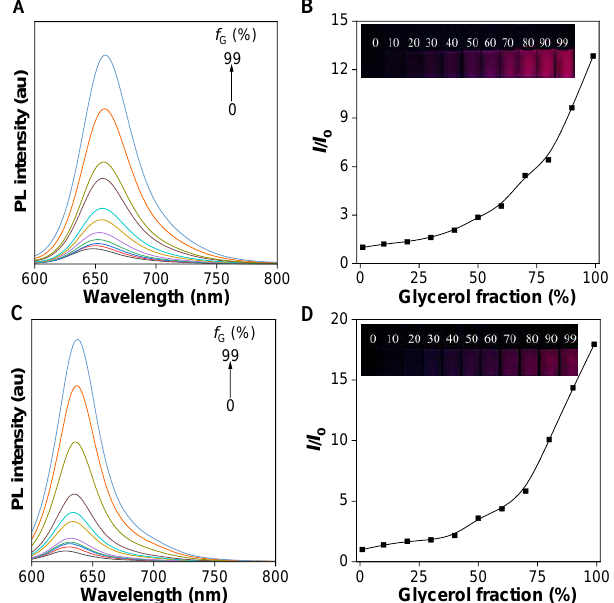
Figure 1. ( A ) PL spectra of TCFISE (5 µ M) in methanol/glycerol mixed solution with different glycerol fractions ( f G ). ( B ) Plot of relative PL intensity (651 nm) of TCFISE (5 µ M) versus glycerol fraction. The inset shows the fluorescent images of TCFISE in solutions with different f G taken under 365 nm UV light. ( C ) PL spectra of TCFIS (5 µ M) in methanol/glycerol mixed solution with different f G . ( D ) Plot of relative PL intensity (629 nm) of TCFISE (5 µ M) versus glycerol fraction. The inset shows the fluorescent images of TCFIS in solutions with different f G taken under 365 nm UV light. λ ex = 575